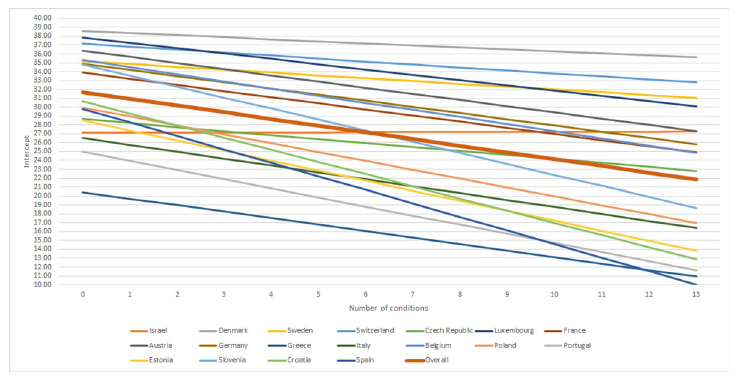
Fig 2. Countries’ intercepts and